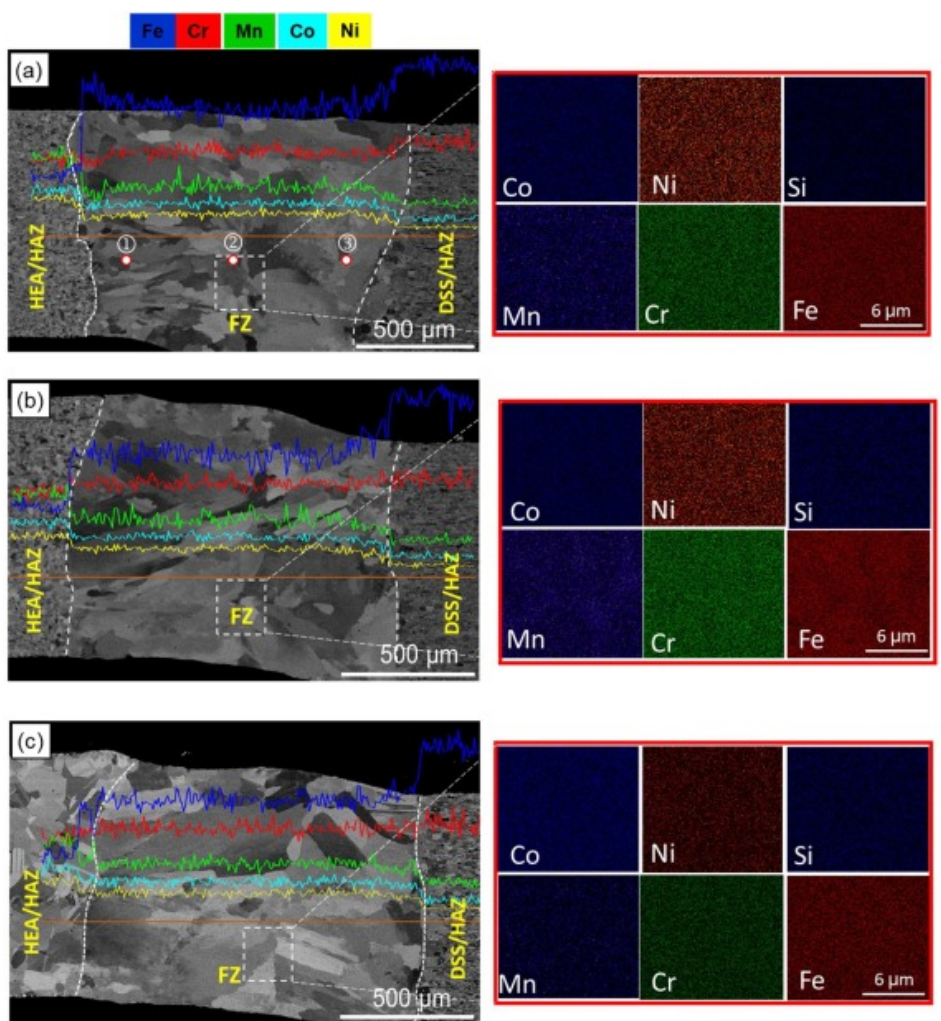
Figure 9. SEM/EDS analysis of ( a ) as-weld, and PWHTed joint ( b ) 800 °C ( c ) 1000 °C. Reproduced with permission from [88]. Copyright Elsevier, 2021.